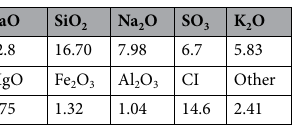
Table 4. Chemical composition of MSWI fly ash(%).